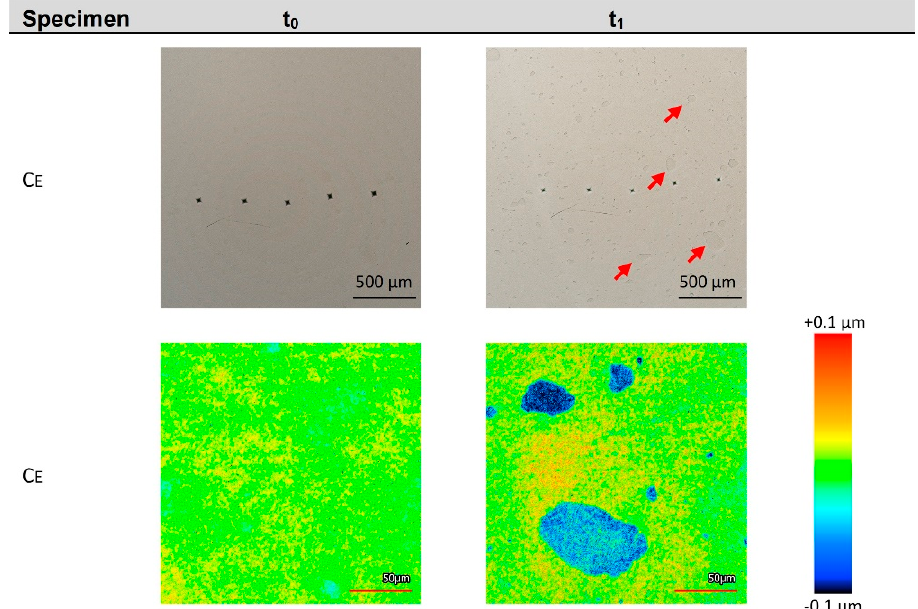
Figure 2. Surface of the C E specimen before (t 0 ) and after (t 1 ) immersion in M HCl . Above: C E overview images of the same specimen location (the five pyramidal indentations of the hardness determination were used as orientation). Multiple darker spots manifested on the C E surface (see red arrows at top right) due to immersion in M HCl . Surface rendering revealed that the spots are depressions. Below: height-scaled false colours.